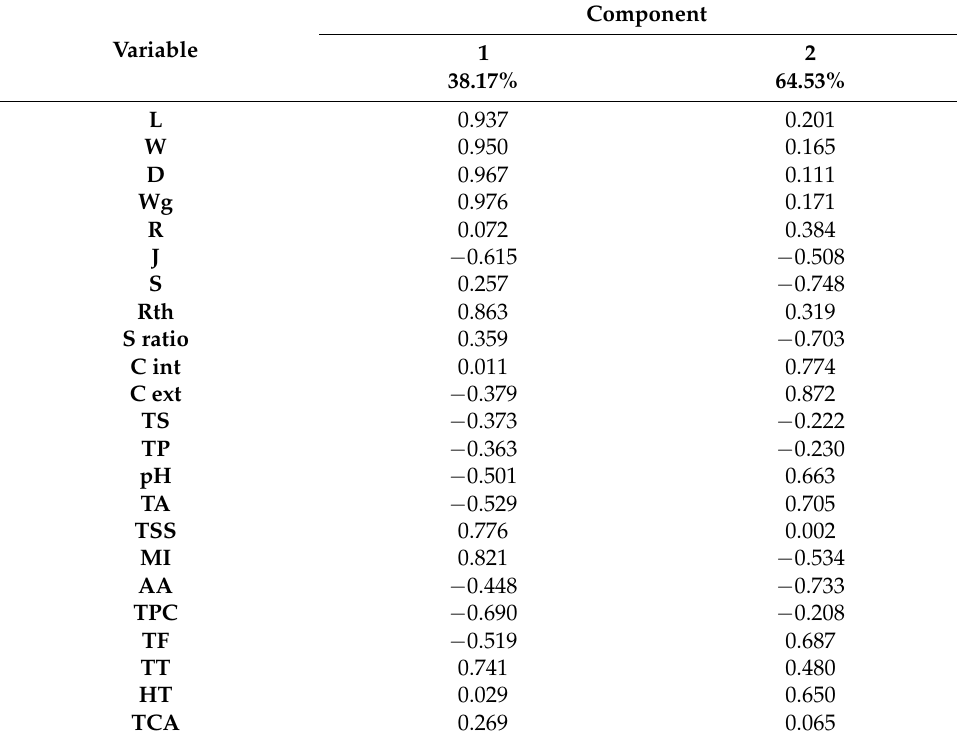
Table 6. Loadings, eigenvalues, and percent of cumulative variance for the first two principal components. Variable